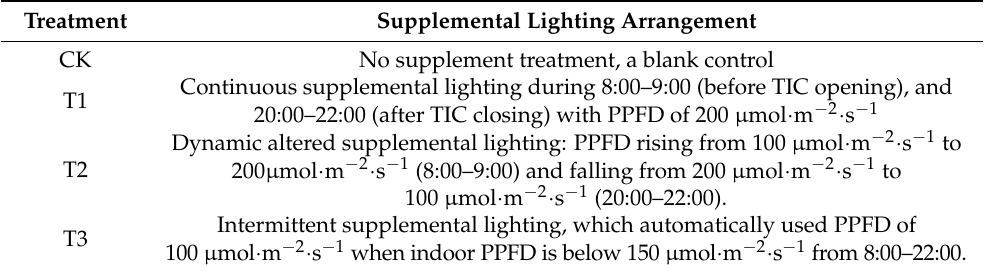
Table 1. The arrangement of different abaxial leafy supplemental lighting